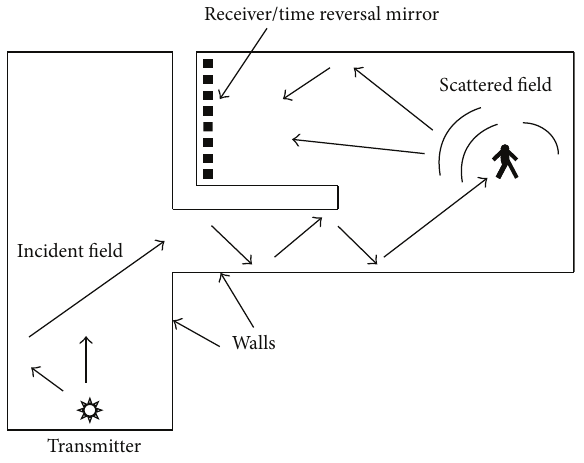
Figure 1: Optical-theorem-based target detection in an indoor